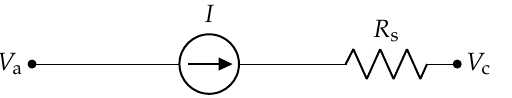
Figure 4. Diode model used in the full wave